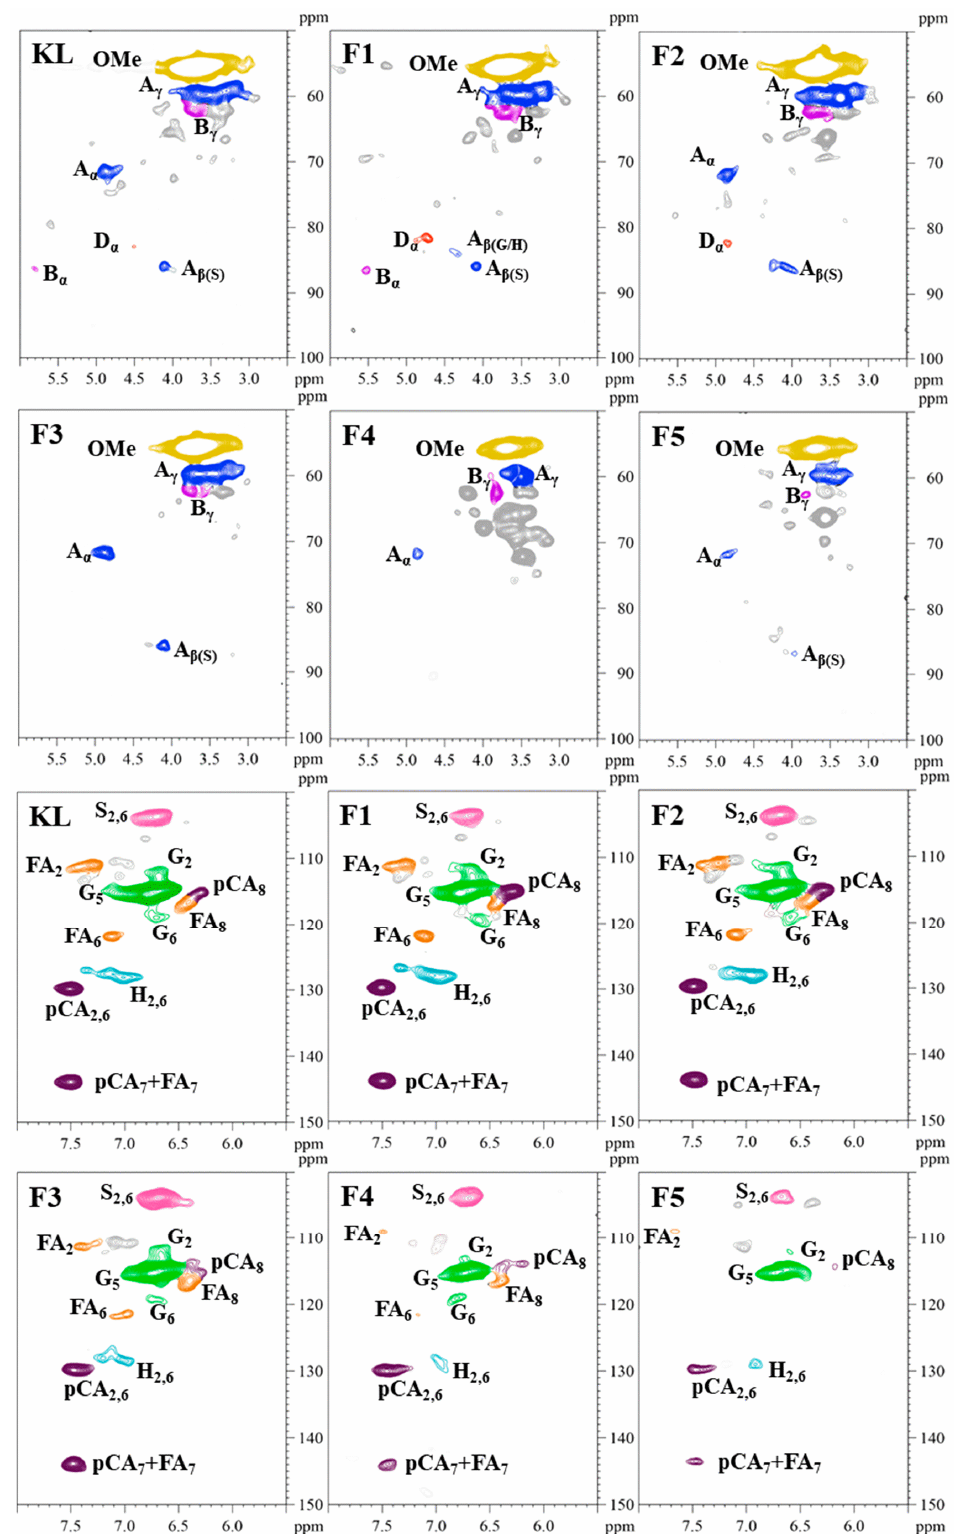
Figure 1. The side chain region ( δ C / δ H 50 － 100/2.5 － 6.0) and aromatic region ( δ C / δ H 100 － 150/5.5